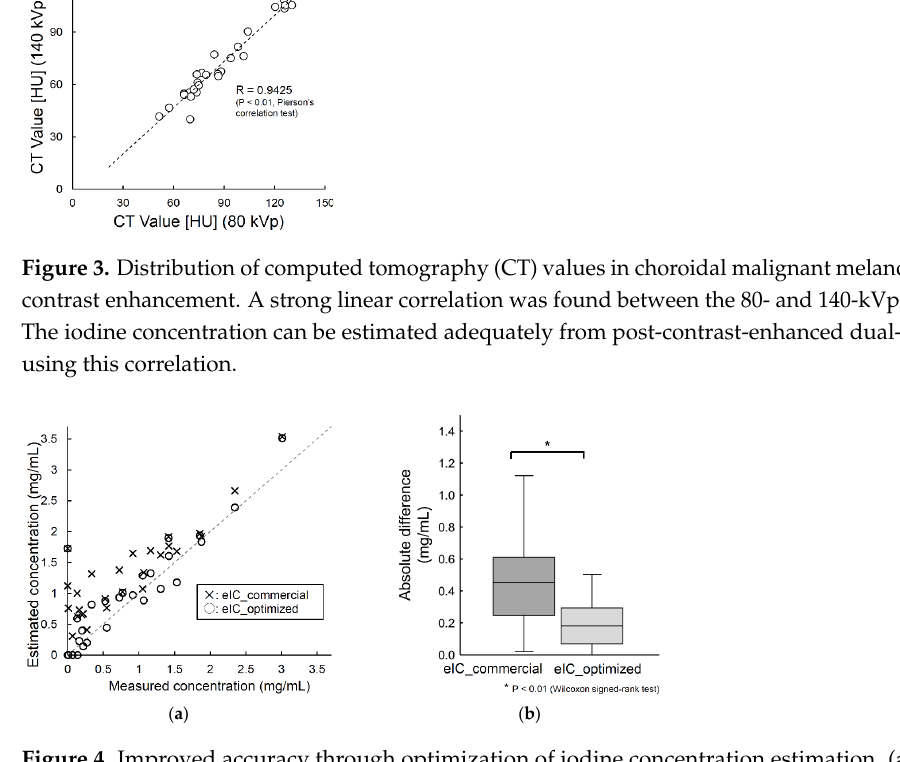
Figure 4. Improved accuracy through optimization of iodine concentration estimation. ( a ) The rela- tionship between the ground truth iodine concentration (GT) obtained from the difference between pre- and post-contrast images, the estimated iodine concentrations obtained by the software equipped in the computed tomography system (eIC_commercial), and the optimized iodine con- centration measurement developed in this study (eIC_optimized). eIC_optimized shows a distribu- tion closer to that of GT than eIC_commercial. ( b ) The difference from GT was significantly smaller in eIC_optimized than in eIC_commercial.